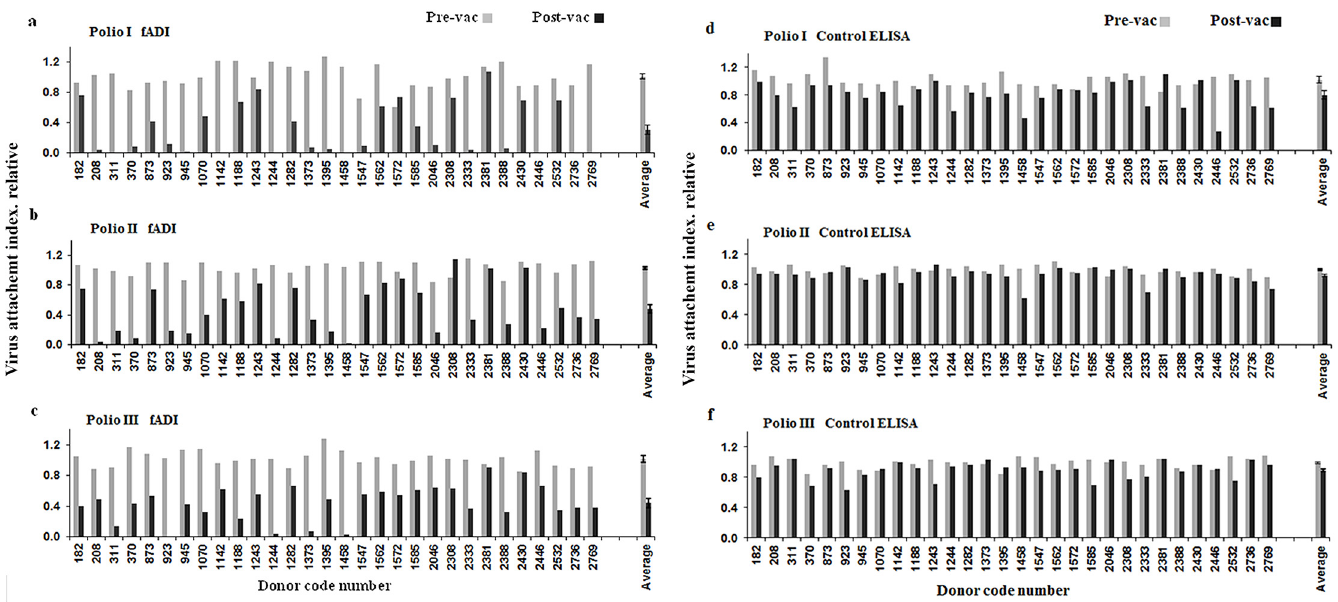
Fig 4. fADI screening of pre- and post-vaccinated serum samples from donors immunized with IPOL 1 vaccine. The screening was performed in the single dilution mode rather than using sera titration. Donor-to-donor variation in the capacity of donor sera to block virus attachment was observed for all three poliovirus serotypes (A, B and C). The control ELISA tests (D, E and F) did not display significant reduction of the reporter fluorescence signal, thus showing very low or zero competition between test serum antibodies and virus-specific labeling antibodies used in the